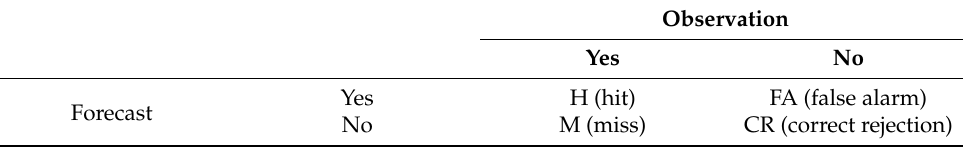
Table 3. The 2 × 2 contingency table for yes/no categorical verification.